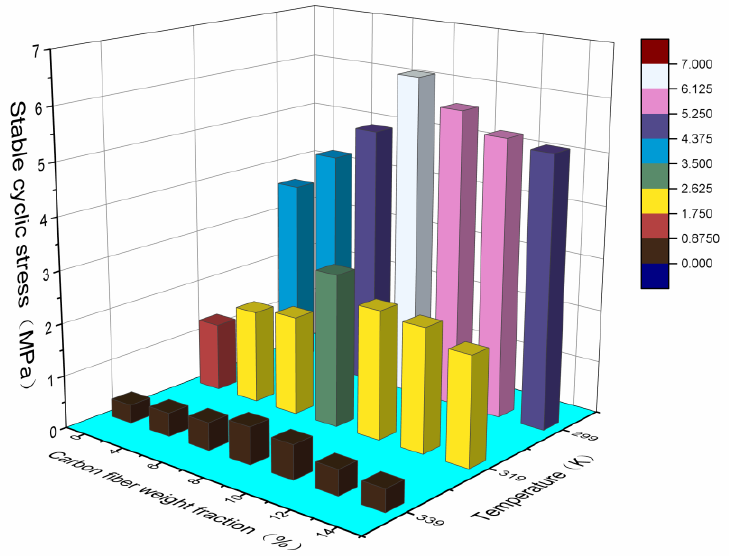
Figure 15. The effect of chopped carbon fiber content on the stable cyclic stress of SMPC specimens at three test temperatures of 299 K, 319 K and 339 K.